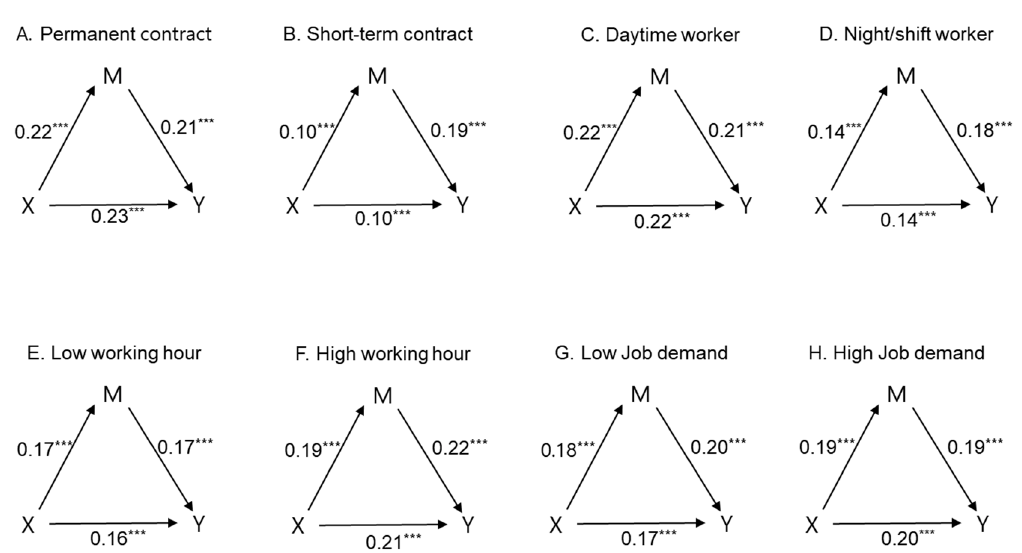
Figure 2. Mediated models showing simple effect for each moderator variable. Mediated models showing simple effects for each moderator variable. Regarding each model, X, M, and Y represent ASB, MSDs, and SP, respectively. Coefficients in boldface were significantly different at p < 0.001 across the level of the moderator variable (Employment contract for Panels A and B , Work schedule for Panels C and D , Working hour for Panels E and F , Job demand for Panels G and H ).